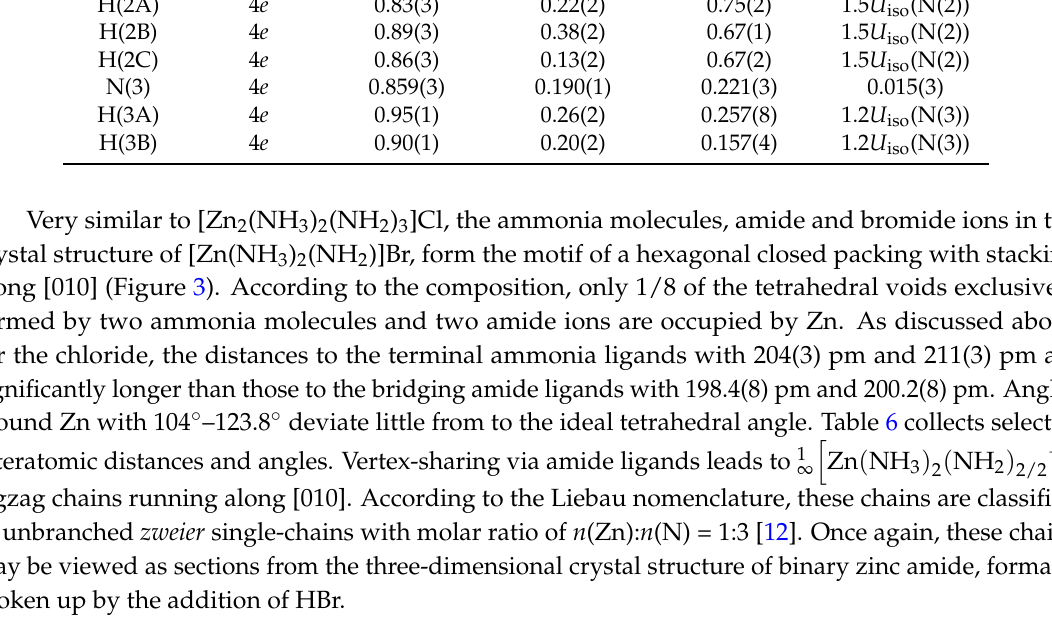
Table 5. Positional and isotropic displacement parameters U iso (10 4 pm 2 ) for [Zn(NH 3 ) 2 (NH 2 )]Br. Atom Site x y z U iso Br 4 e 4 e